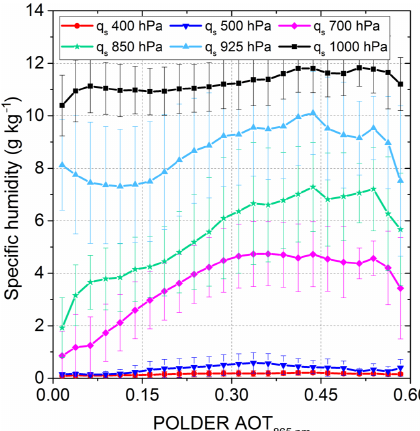
Figure 7. Mean specific humidity as a function of POLDER AOT 865nm retrieved at different pressure levels, within the selected region over June–August 2008. The vertical bars represent the stan- dard deviation for the specific